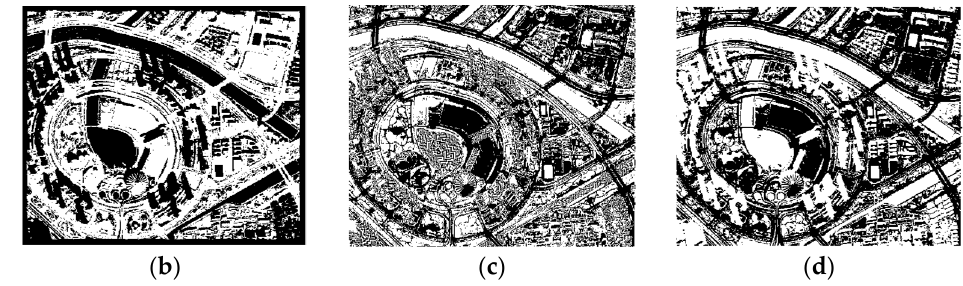
Figure 12. Segmentation results of WorldView-2 satellite remote sensing image 5: ( a ) original remote sensing image; ( b ) TPSCA–PCNN segmentation result; ( c ) PCNN segmentation result; ( d ) ELM segmentation result.